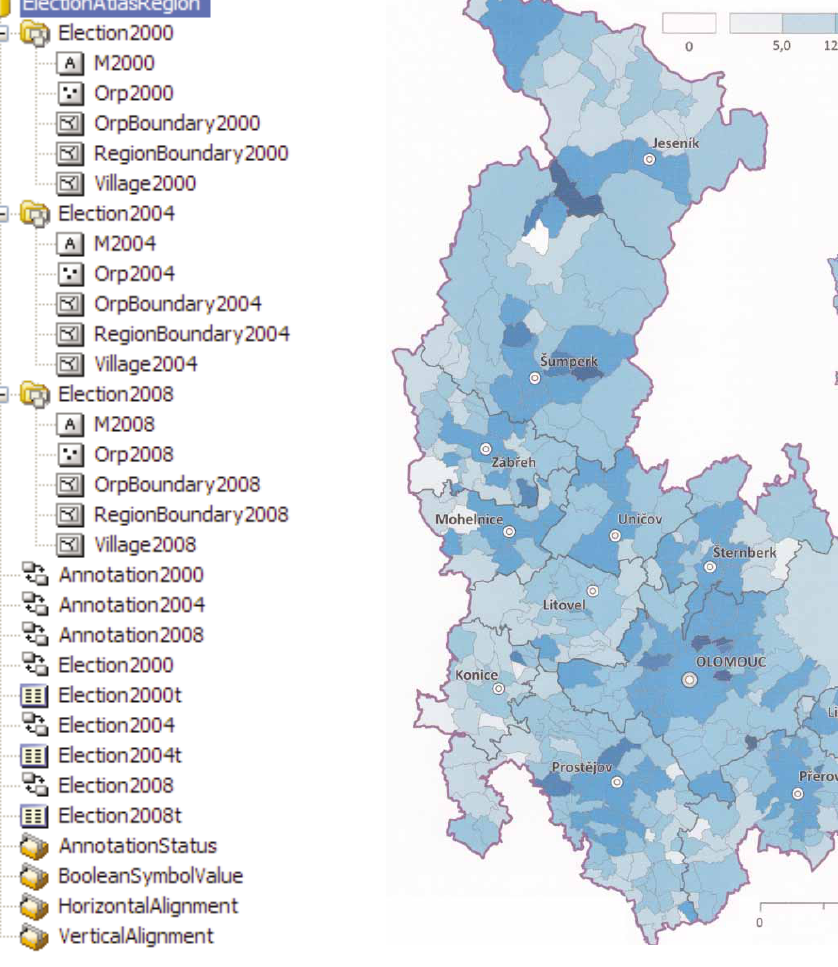
Fig. 4. Structure of the file geodatabase in ArcCatalog after import from the XML